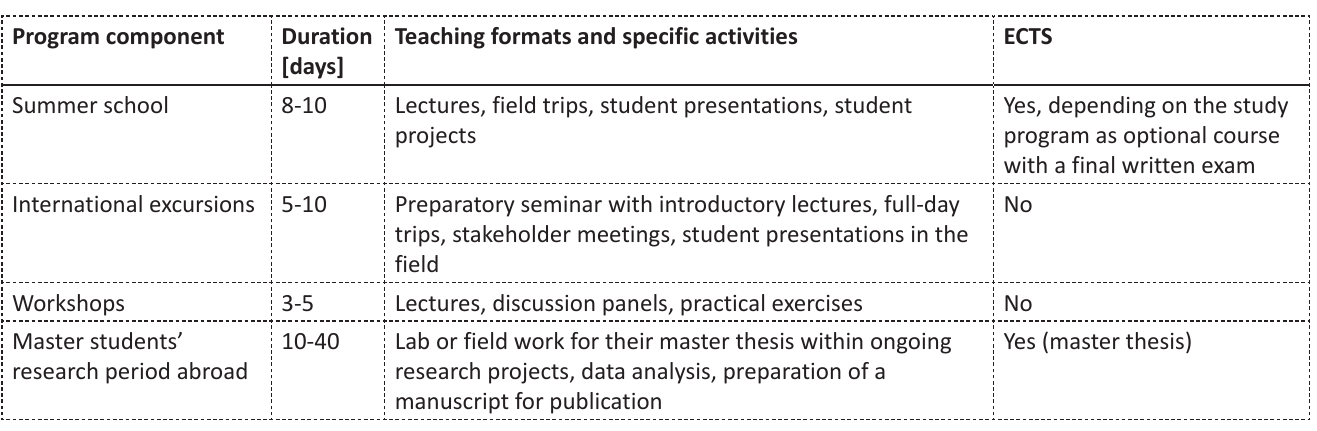
Table 1: Components of the study-abroad program with duration, teaching formats and specific activities, and eventual credits